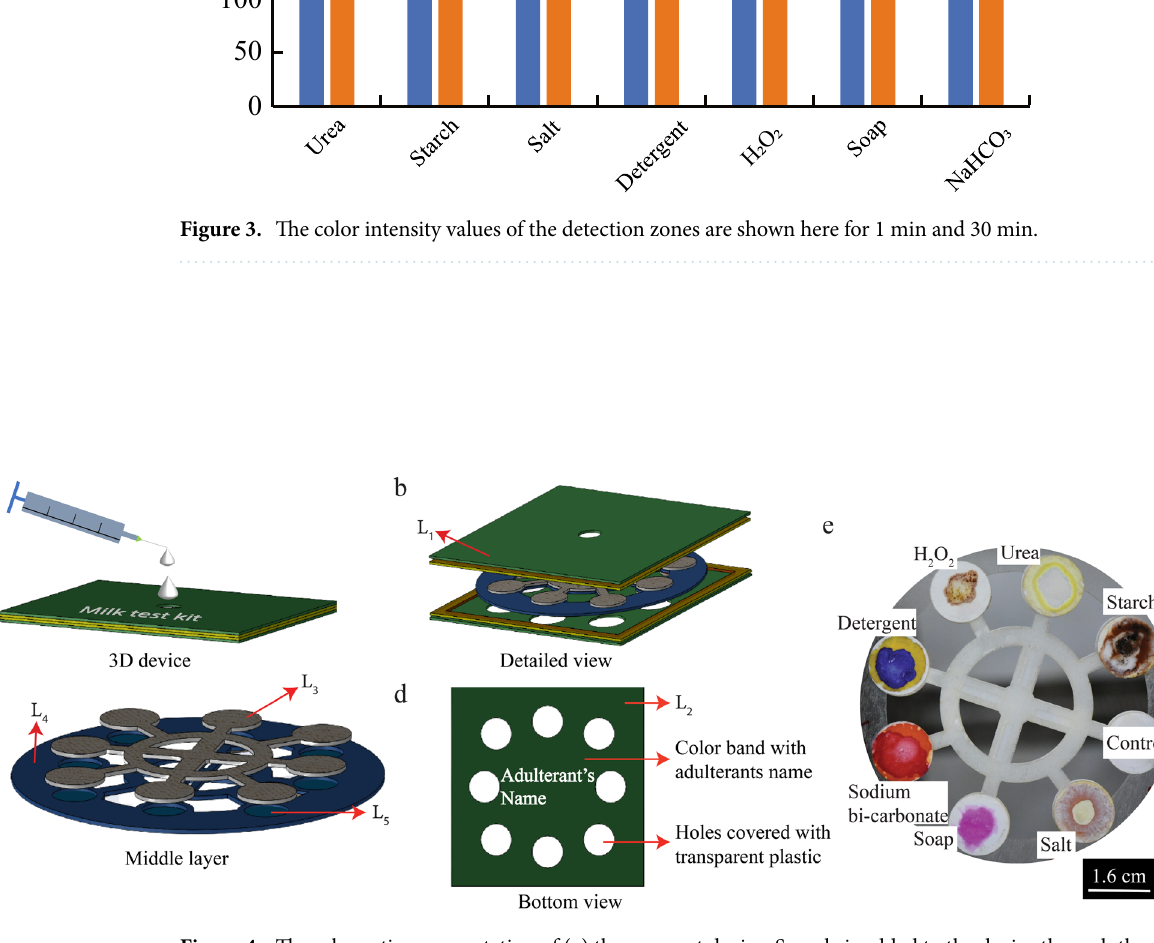
Figure 4. The schematic representation of ( a ) the compact device. Sample is added to the device through the hole in the top cover, for testing. ( b ) Device’s detailed view. Three layers have been shown here as the top cover ( L 1 ) , 3 D paper-based microfluidic device, and the bottom cover ( L 2 ) . ( c ) The double layers 3 D paper-based microfluidic device is shown here. This is a sandwich structure where solid support is sandwiched between two layers of filter paper. L 3 represents the transportation zone, L 4 represents the solid plastic layer, and L 5 represents the detection zone. ( d ) Design on the backside of the bottom cover. Adulterants name and a color band are given for qualitative and quantitative identification. ( e ) Image of simultaneous detection of the seven adulterants using the 3D paper-based microfluidic device is shown (only the middle